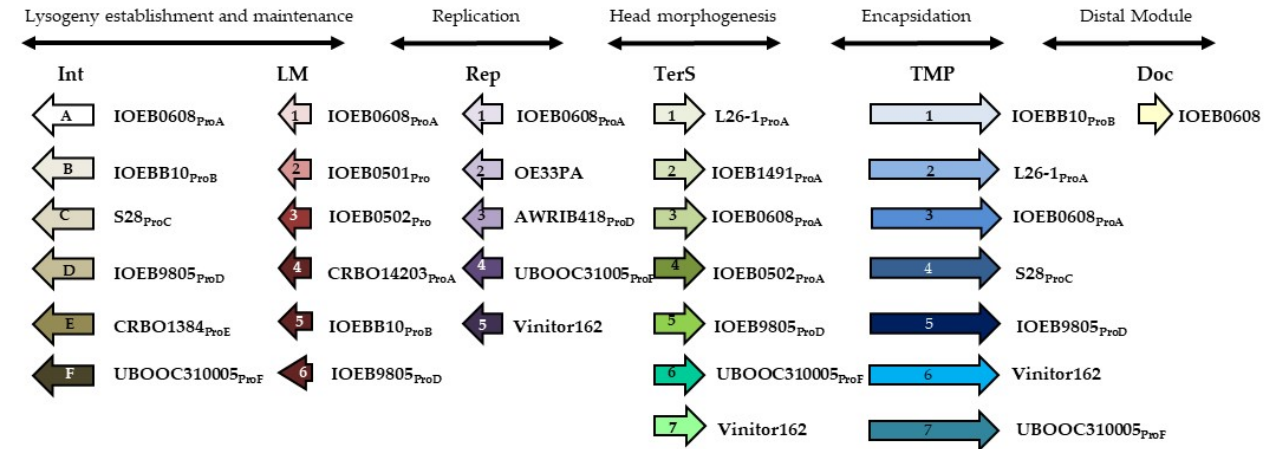
Figure 2. Scheme for the classification and rapid genotyping of oenophages. LM, lysogeny maintenance; Rep, replication-associated protein; TerS, small unit of the terminase; TMP, tape measure protein; Doc, toxin–antitoxin system. Representative phages containing the genes encoding the distinct proteins are indicated. Pro indicates that the phage is a prophage. Because some strains are poly ‐ lysogens, the integrase type (A to F) is also indicated.